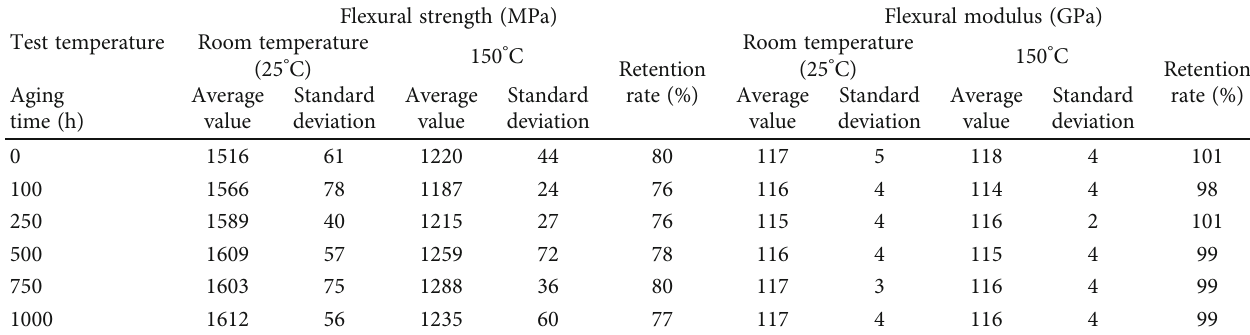
Table 6: The thermal aging properties of CCF800/5228 composites — fl exural strength and modulus.